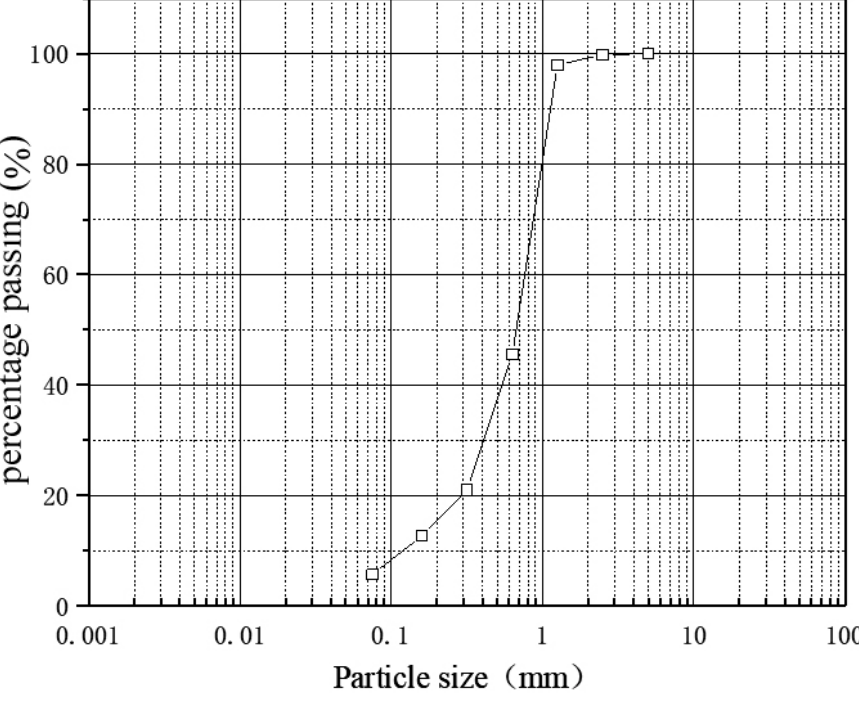
Figure 1. Grain grading curve of